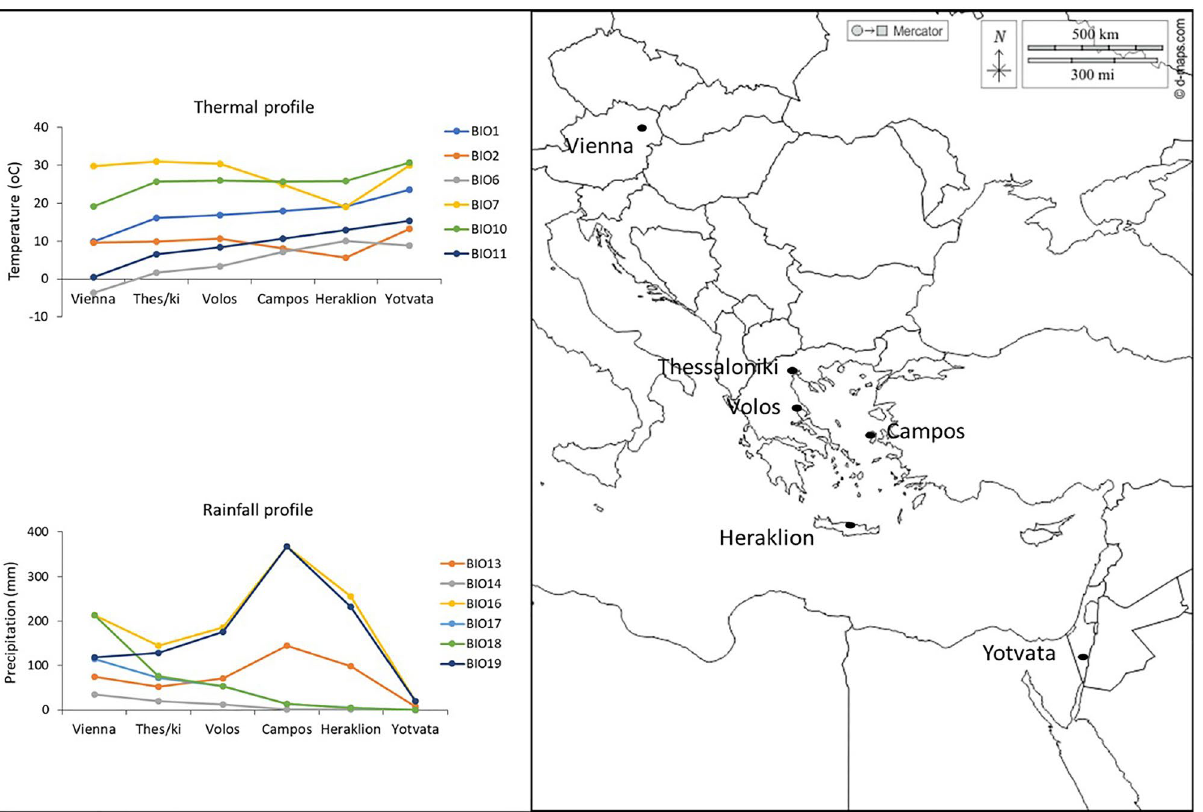
Figure 2. Map with the six collection sites for Ceratitis capitata populations. Climatic data of the six sites based on bioclimatic variables extracted from WordClim database (v2.1; current data 1970–2000; www. world clim. org ) using latitudinal and longitudinal coordinates (0.5 min spatial resolution). Bioclimatic variables: Mean annual temperature (BIO1), mean diurnal range (BIO2), min temperature of coldest month (BIO6), temperature annual range (BIO7), mean temperature of the warmest quarter (BIO10), mean temperature of the coldest quarter (BIO11), precipitation of the wettest month (BIO13), precipitation of the driest month (BIO14), precipitation of the wettest quarter (BIO16), precipitation of the driest quarter (BIO17), precipitation of the warmest quarter (BIO18), precipitation of the coldest quarter (BIO19). The map template obtained from https://d- maps. com .